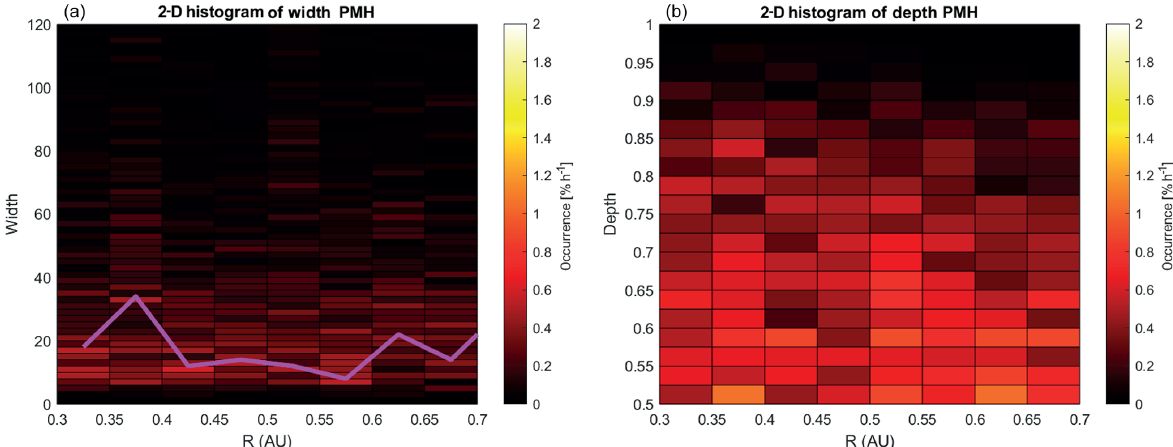
Figure 8. 2-D histogram of the occurrence rate of (a) the width (in seconds) and (b) the depth of the PMHs as a function of radial distance from the Sun. In panel (a) the green line shows the maximum occurrence rate in each radial bin.